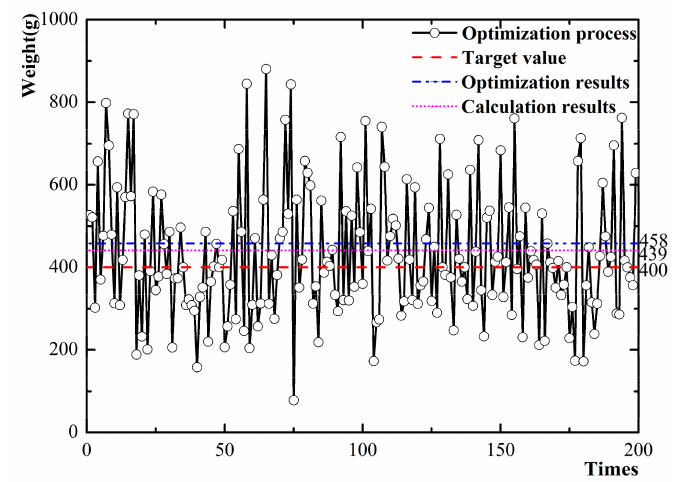
Figure 9. Weight optimization process, optimization results, and calculation